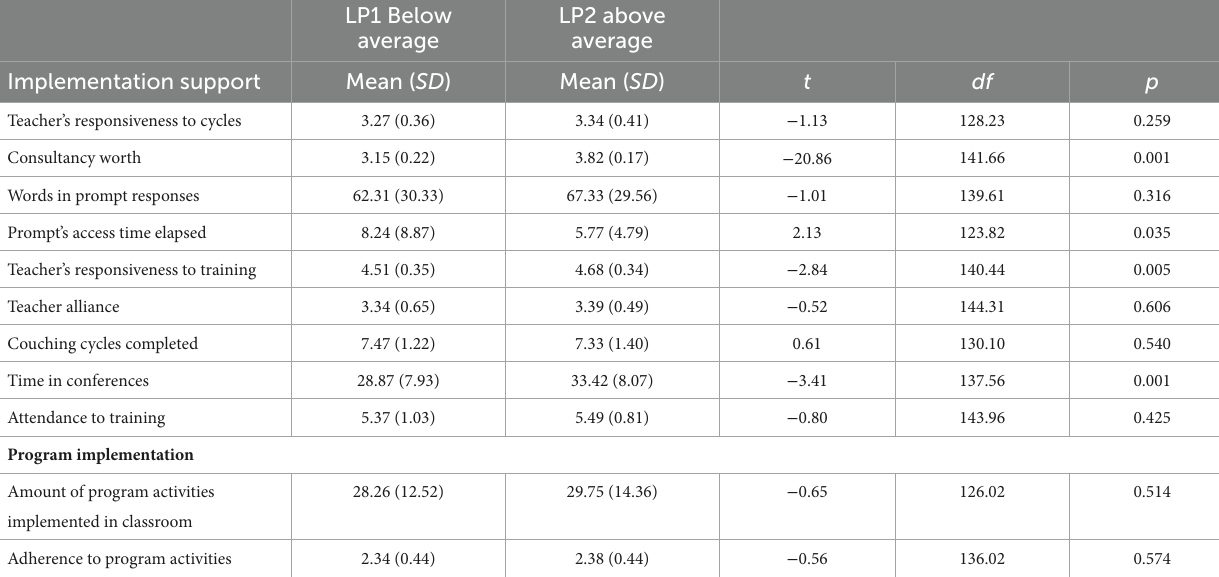
TABLE 7 Mean differences of quality of implementation constructs by latent